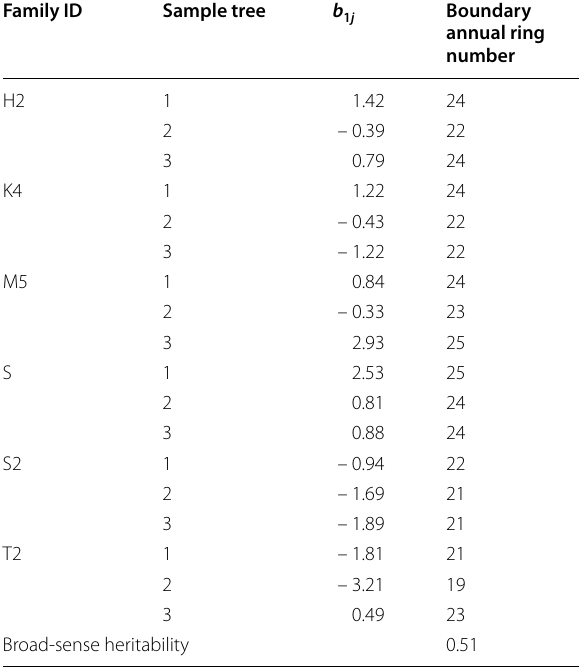
Table 5 Boundary between juvenile and mature wood based on radial variation of latewood tracheid